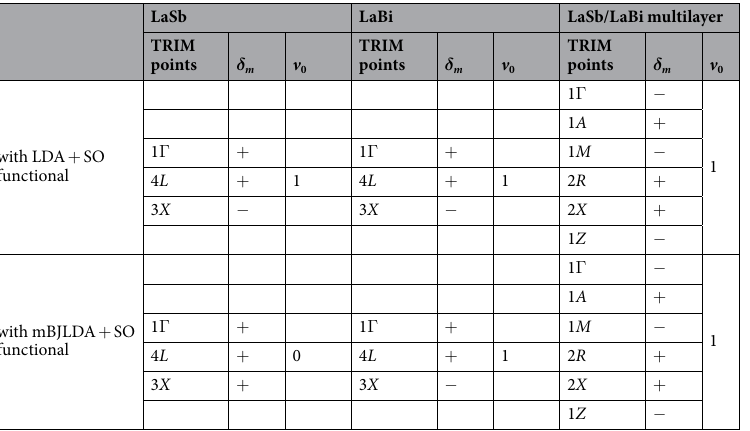
Table 1. Calculation of  index for LaSb, LaBi and their heterostructure with LDA + SO and mBJLDA + SO 2 functionals using Eq. 1. As seen, LaBi 38,44 and LaSb/LaBi heterostructure possess a non-trivial  indicating their non-trivial topological character. On the other hand, v 0 changes from 1 to 0 for LaSb, when we introduce the mBJ potential, thus confirming the topologically trivial nature of